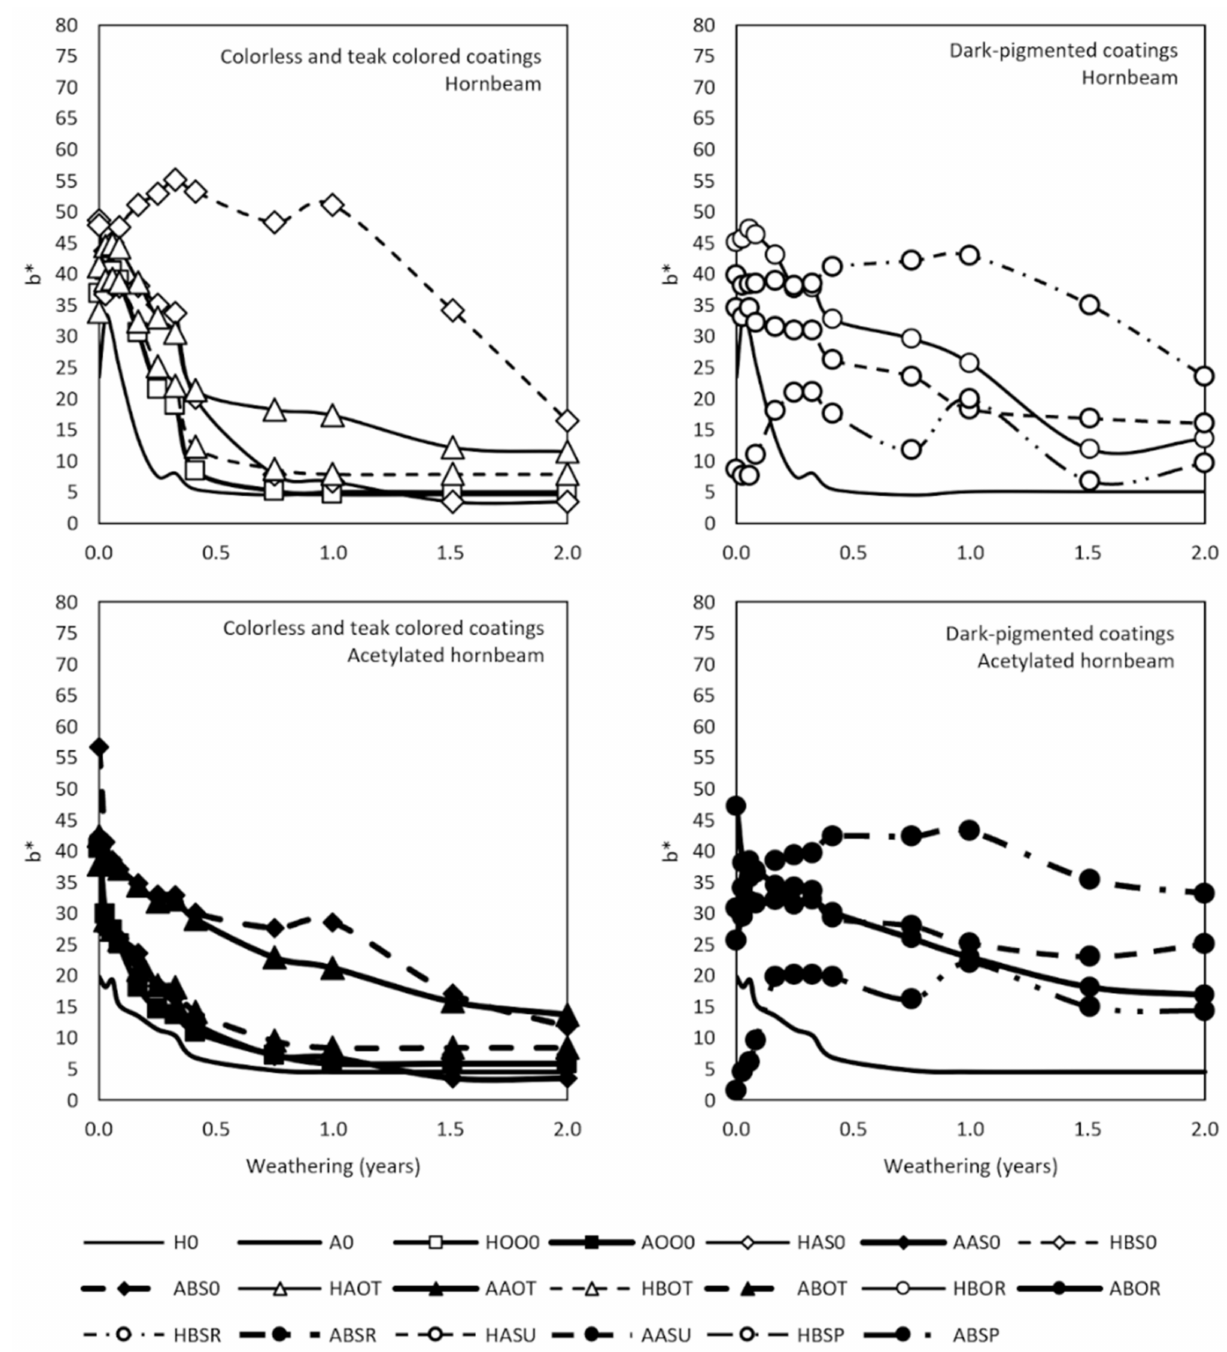
Figure 10. Change of yellow hue (b*) during two-year-long weather exposure. Colorless coatings had a high rate of ∆ E* in the first five months. At about 5–9 months, the surface started to grey, and the rate of change decreased greatly after one year. The greatest ∆ E* in colored coatings was in BOR, BOT, and AOT. In most cases, coated acetylated hornbeam had lower ∆ E* than hornbeam at the end of the exposure. Moreover, its trend curve was flatter. BSR, BSP, and ASU achieved the lowest ∆ E* (Figure 11). S-Shaped and convex deterioration patterns can also be found in the diagrams